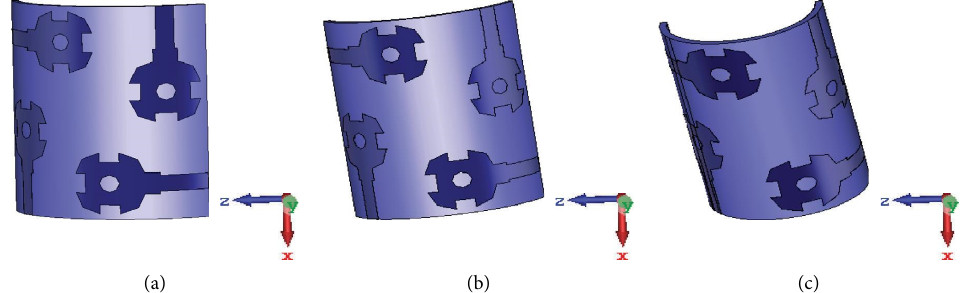
Figure 14: Simulated bending analysis of the MIMO antenna: (a) r � 25 mm, (b) r � 20mm, and (c) r � 15mm.